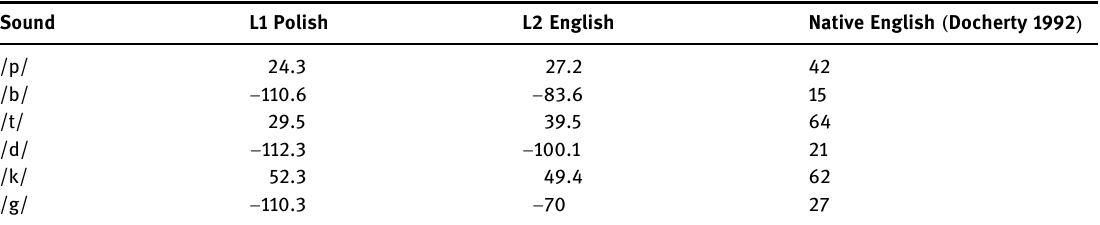
Table 2: Mean results of VOT in ms for L1 Polish and L2 English in the research group